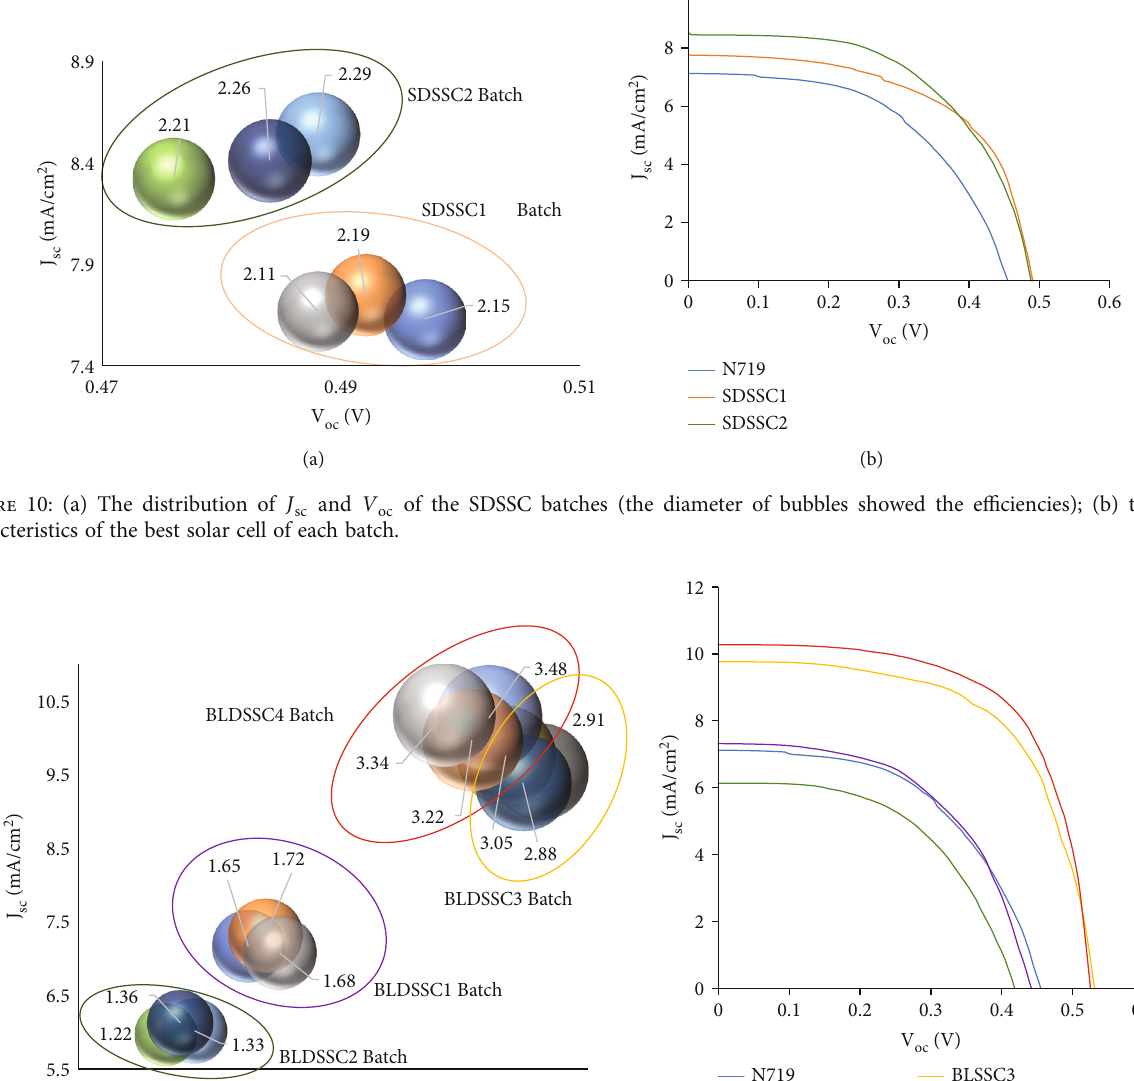
ffi ciencies); (b) the J - V